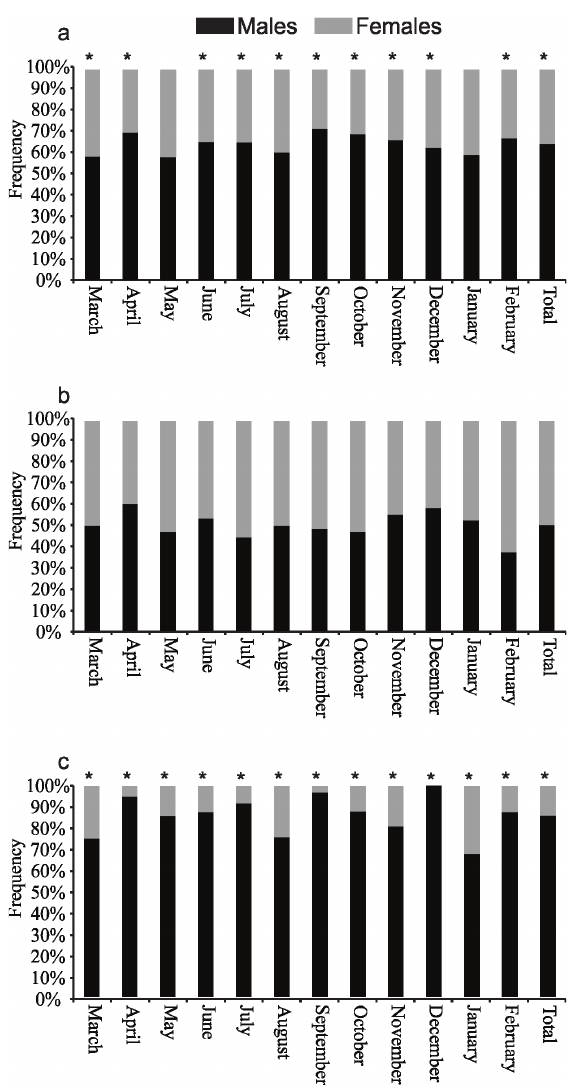
Figure 3. Aegla schmitti : Sex ratio in the Capivari River. a: Combined data. b: Animals sampled with handnets. c: Animals sampled with traps. * = significant difference according to the Chi-squared